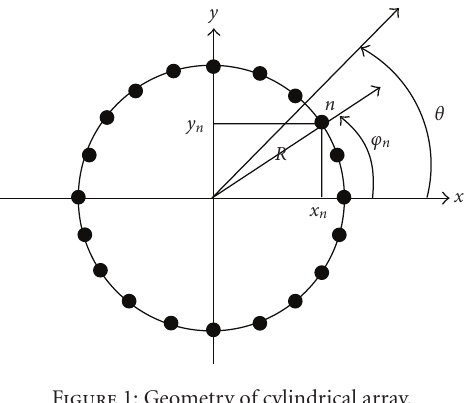
Figure 1: Geometry of cylindrical array.